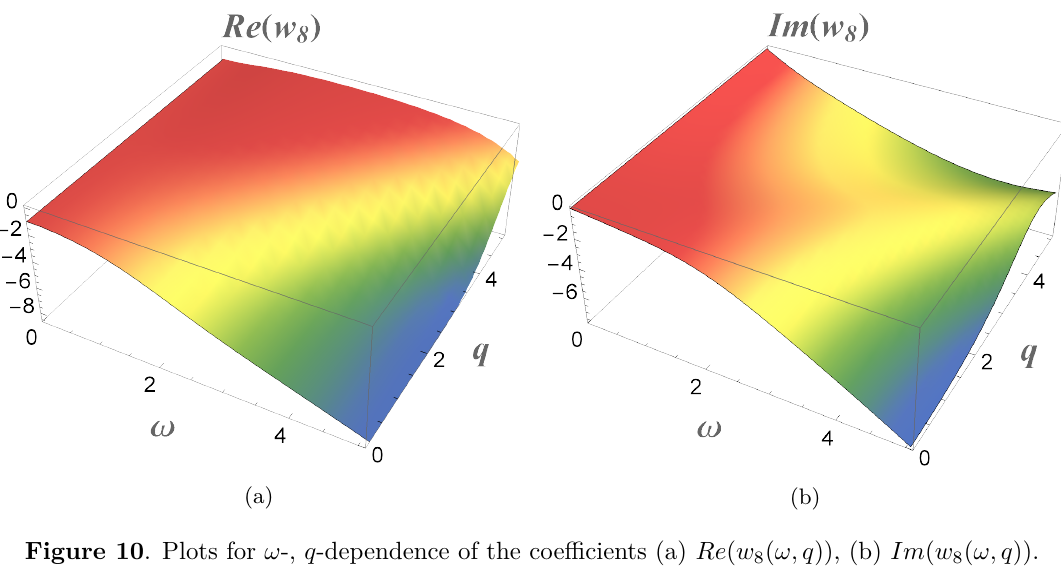
Figure 10 . Plots for ω -, q -dependence of the coefficients (a) Re ( w 8 ( ω, q )) , (b) Im ( w 8 ( ω, q )) .